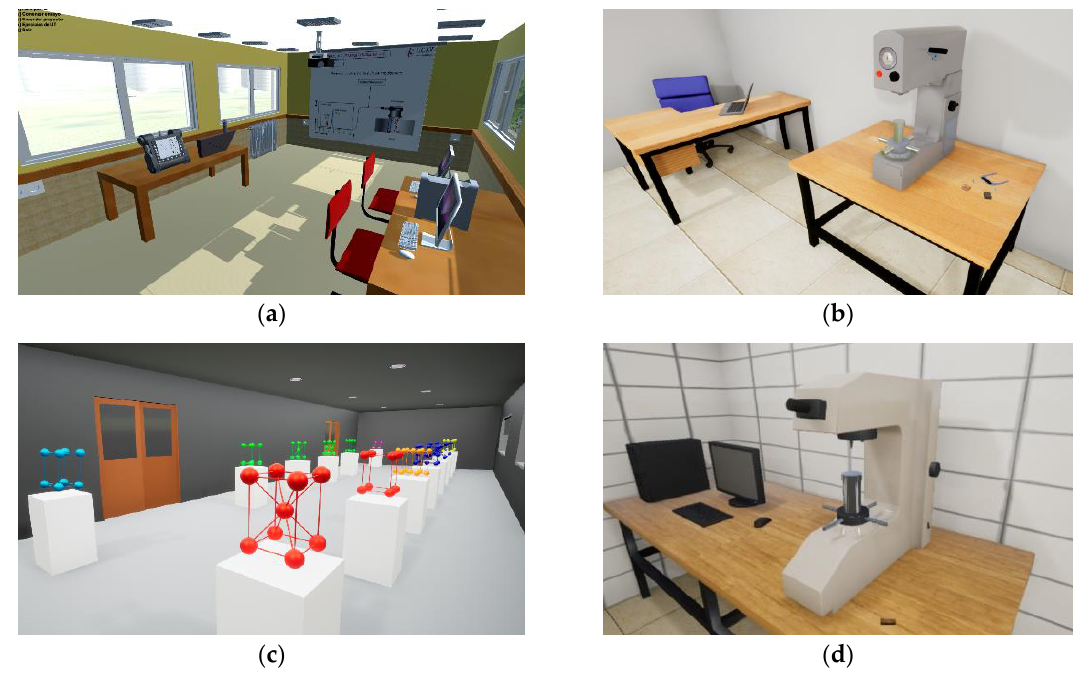
Figure 2. More recent VRLEs designed with newer VR software: ( a ) ultrasonic testing; ( b ) Rockwell hardness testing; ( c ) crystal lattices analysis; and ( d ) Vickers hardness testing. hardness testing; ( c ) crystal lattices analysis; and ( d ) Vickers hardness